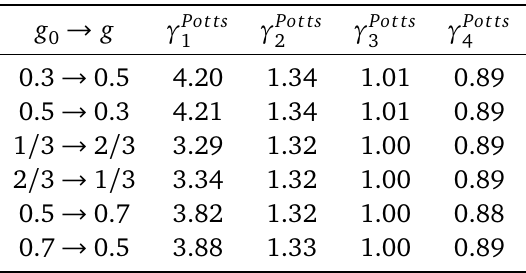
for various transverse n